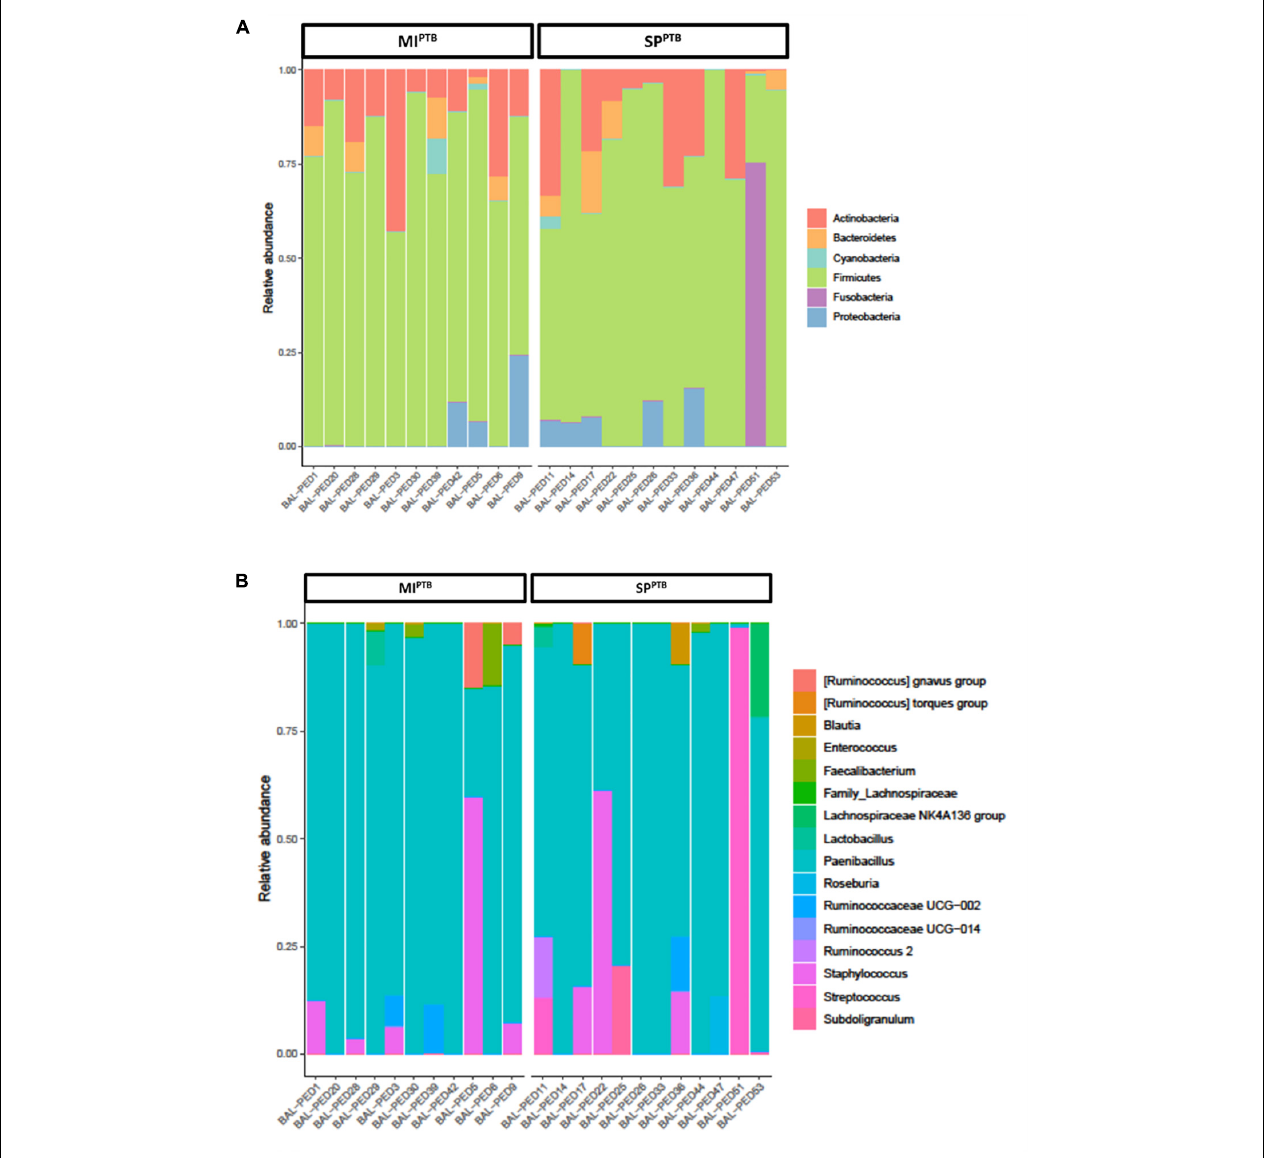
FIGURE 1 | Relative abundances of bacterial taxa composing the lung bacterial communities in hospitalized newborns. For each sample of the MI PTB and SP PTB infants’ groups, proportions for major phyla (A) and major genera (B) were computed, normalized, and presented as stacked bar plots. The statistical significance at a P -value of ≤ 0.05 was assessed using the Mann–Whitney U